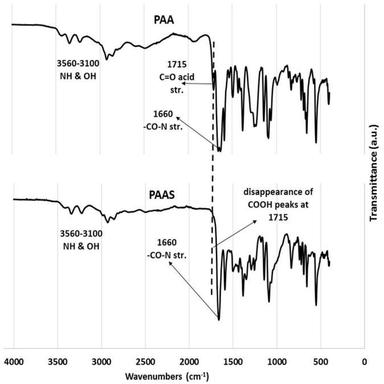
The FTIR spectra of the PAA and PAAS precursor resins.